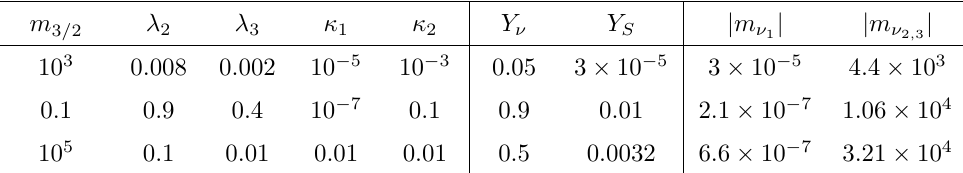
Table 3 . Three benchmark points in the parameter space that give the active neutrino masses | m ν | ∼ O (0 . 1) eV and satisfy the constraints from inflation observables and reheating. All mass l scales are given in